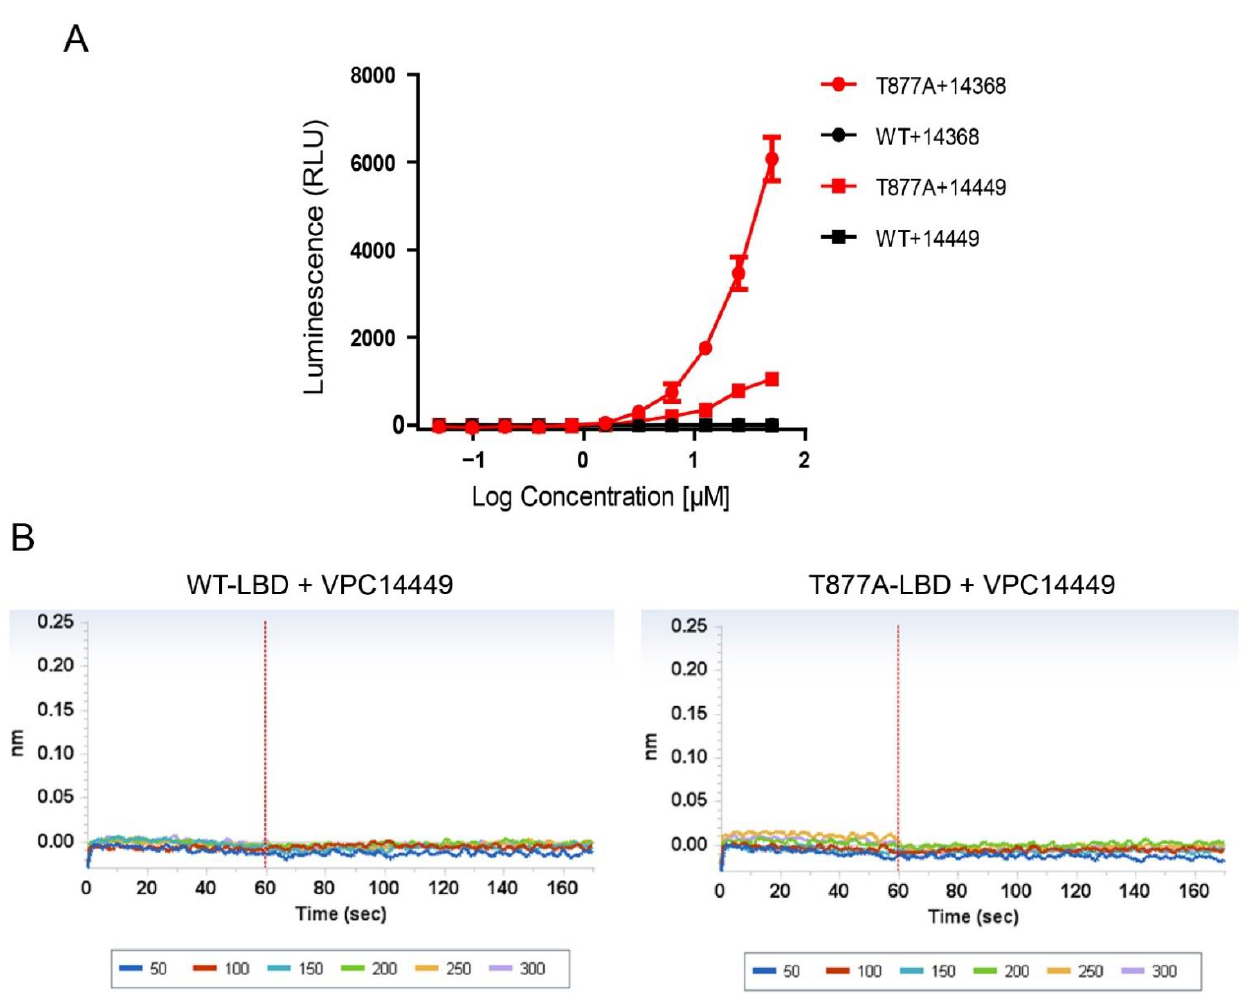
Figure 6. ( A ) Luciferase reporter assay showing the effect of VPC14368 and VPC14449 on AR transcriptional activity in PC3 cells transiently transfected with either WT-AR or T878A-AR mutant in the absence of R1881. ( B ) BLI curves showing that VPC14449 is not binding to wild-type-LBD neither to T878A mutant.